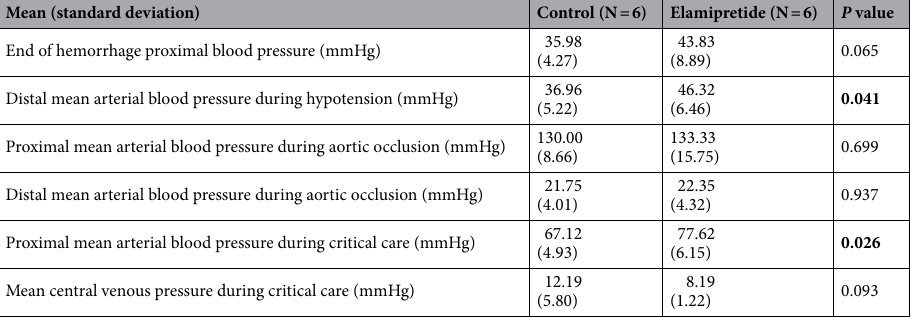
Table 2. Hemodynamic parameters over time. 1000 Hz sampled data is taken as an average during the period of interest. Significant values are in bold.